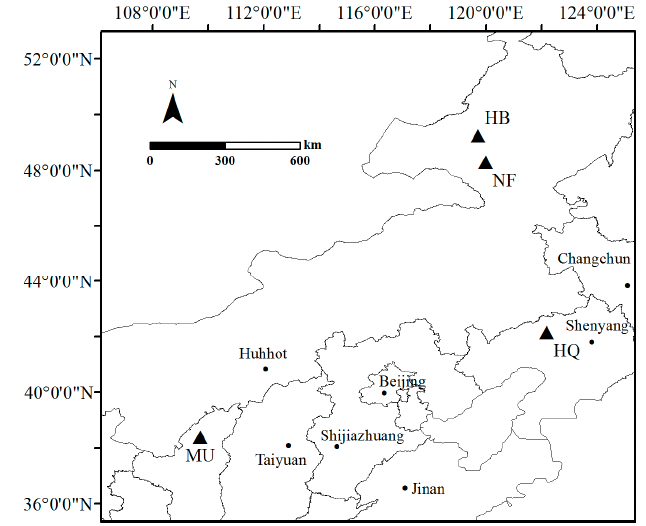
Figure 1. The location of study sites. NF: natural forest; HB: the Hulunbuir Sandy Land; MU: the Mu Us Sandy Land; HQ: the Horqin Sandy Land.